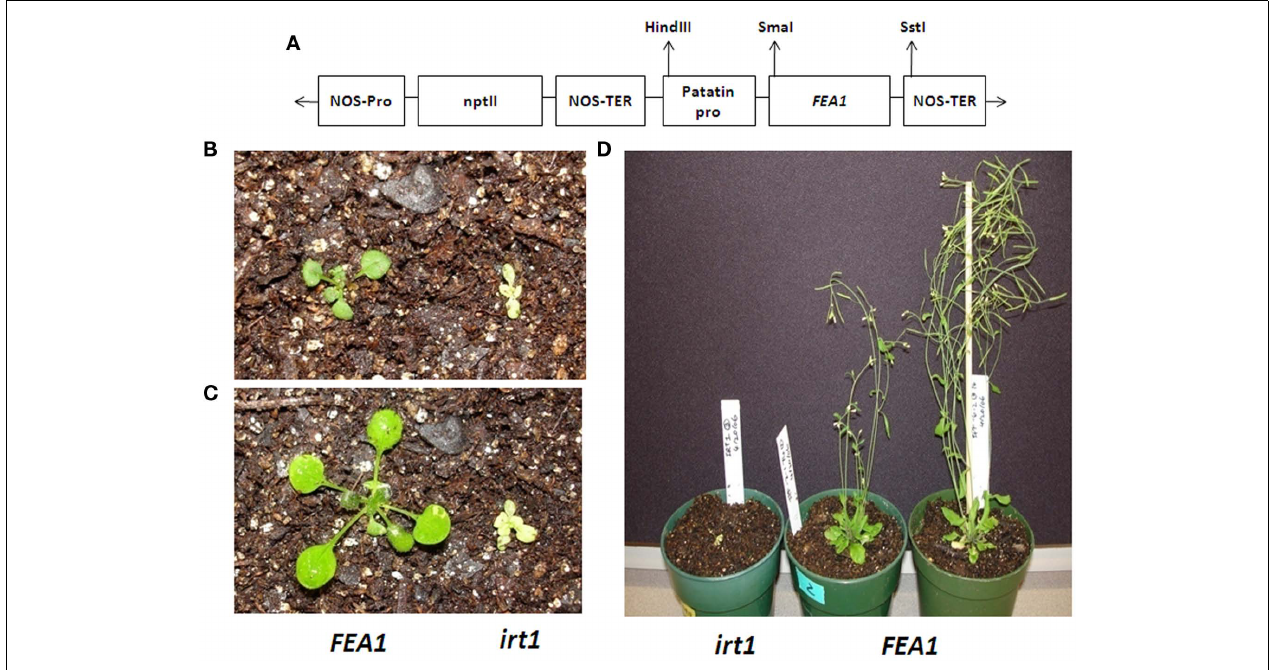
FIGURE 2 | FEA1 complements Arabidopsis irt1 mutant. (A) TheT-DNA region pBI121 containing patatin promoter and FEA1 gene used in the transformation of Arabidopsis mutant line irt1 (B) Growth of irt1 mutant and irt1 mutant and wild-type complemented with the FEA1 at the four- to six-true-leaf stage (day 1), (C) day 5, (D) day